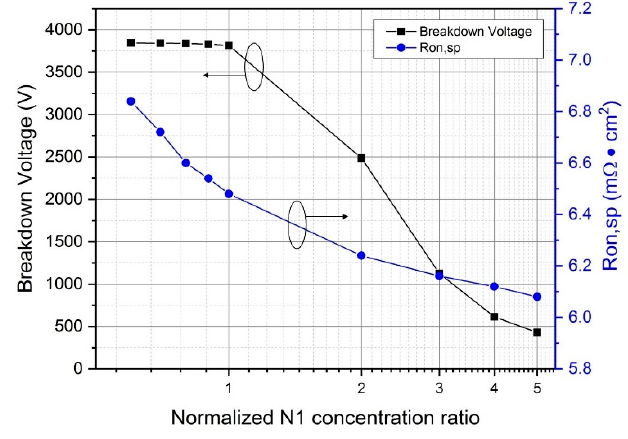
Figure 4. Relationship between different N1 epitaxial layer concentration ratios and the breakdown voltage and R on,sp .